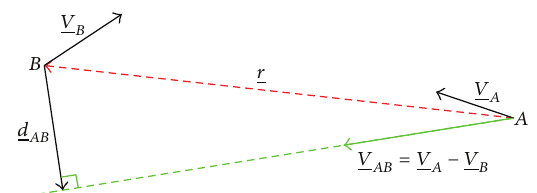
Figure 1: Definition of minimum separation distance vector 𝑑 𝐴𝐵